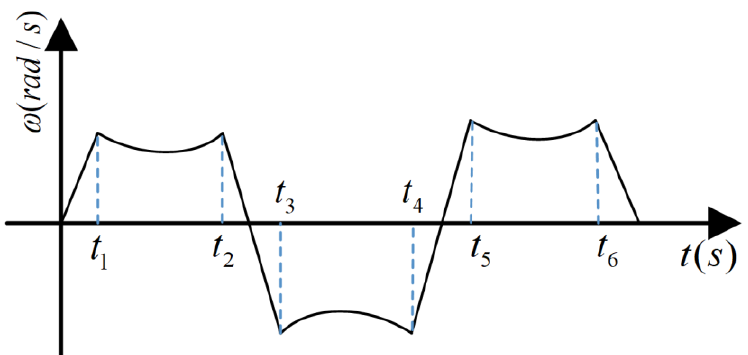
Figure 3. ( a ) The double moving mirror torsion pendulum structure. ( b ) A schematic diagram of the relationship between the OPD and the swing angle.